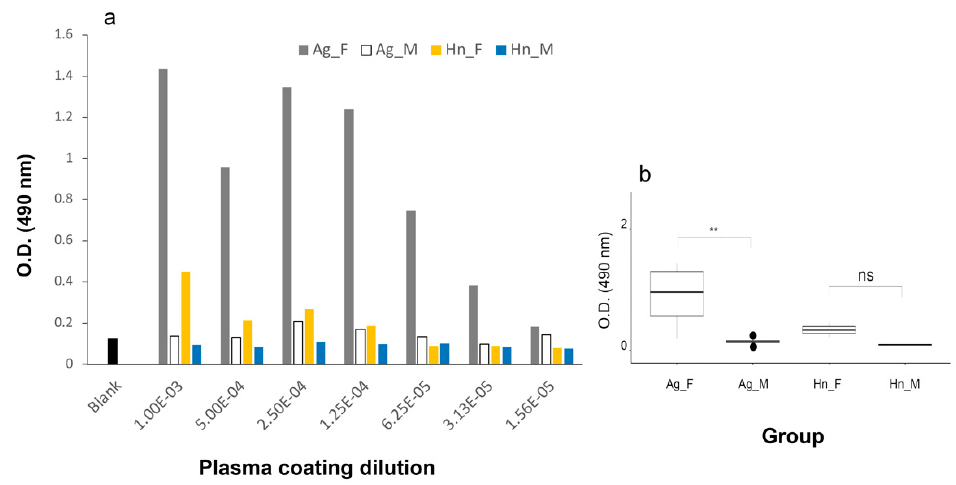
Figure 3. Dilution series of male and female Pirarucu, Arapaima gigas , and African bonytongue, Heterotis niloticus , plasmas revealed with Arapaima gigas Vtg1 antibodies in ELISA, ODs at 490 nm. Blank (plate + reagents background) received all reagents except the coating one ( a ). Box plots of Statistical analysis of ODs by ANOVA, rstatix ( b ). ** indicates significant statistical differences between male and female coating dilutions range ( p = 0.003), ns indicates non-significant difference ( p = 0.87), Tukey HSD with p adjust. Ag_F: Arapaima gigas female; Ag_m: Arapaima gigas male; Hn_F: Heterotis niloticus female; Hn_M: Heterotis niloticus